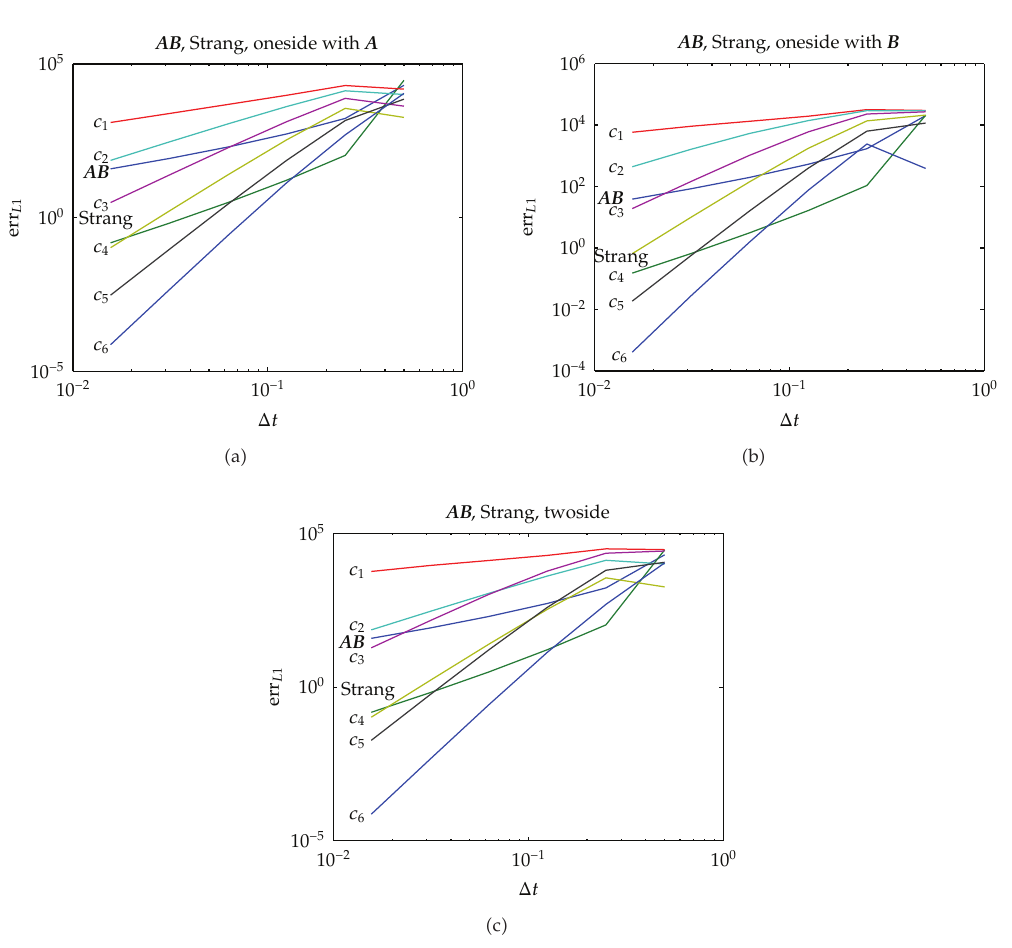
Figure 7: Numerical errorsof the standard splitting scheme (cid:5) a (cid:6) and the iterative schemes based on one-side to operator A or B (cid:5) b (cid:6) and two-side scheme (cid:5) c (cid:6)